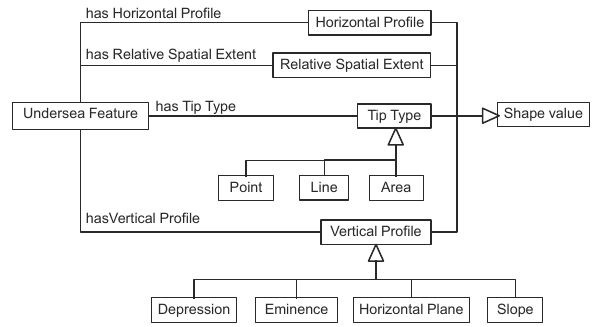
Figure 5: The shape concept describing a feature, based on (Yan et al., 2014)